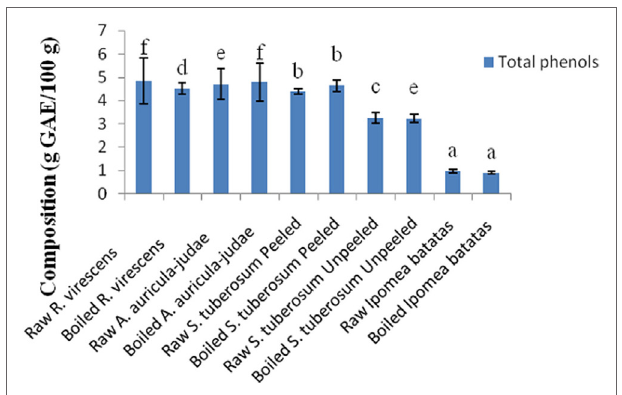
FigUre 1 | Total phenol contents of aqueous extracts of raw and boiled mushrooms, potato, and sweet potato. Values are reported as means ± SD. (a–f) Means with different superscripts are significantly different ( P < 0.05) across the groups. GAE, gallic acid equivalence.